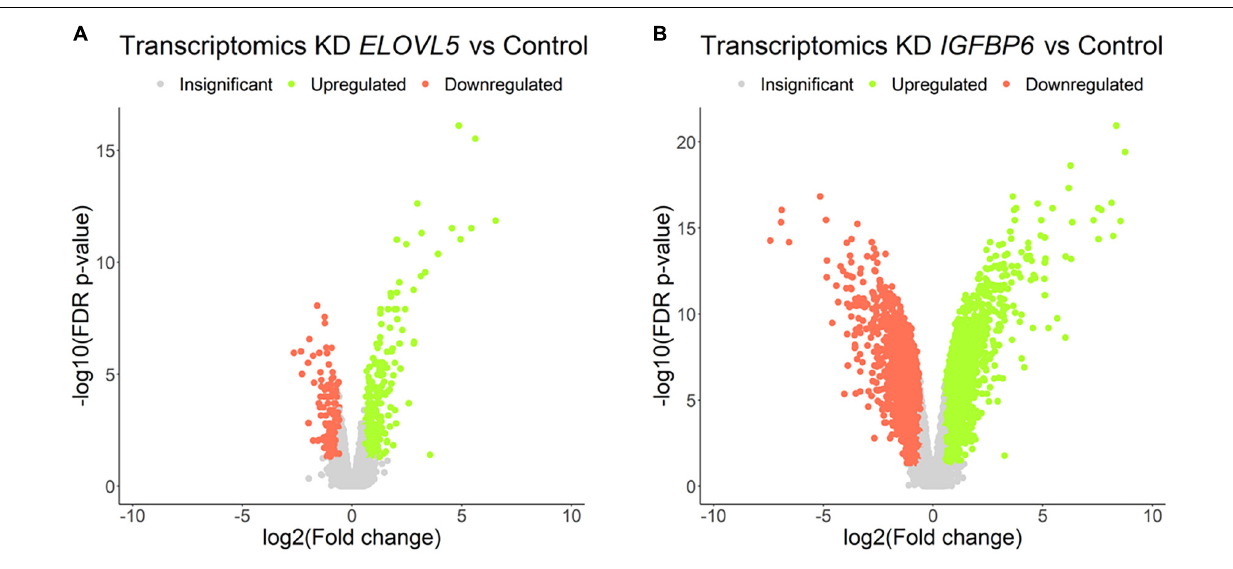
FIGURE 7 | Volcano plots for comparative transcriptome analysis of the cells with a stable knockdown of (A) ELOVL5 and (B) IGFBP6 genes. Thresholds: Fc = 1.5, FDR p -value =